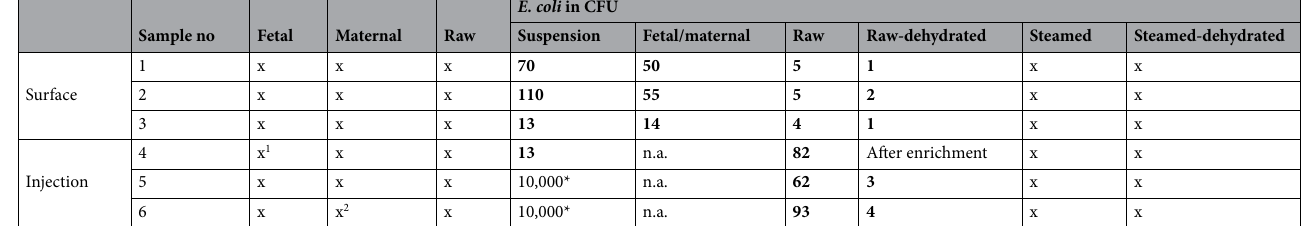
Table 5. Growth of E. coli in colony forming units (CFU) on different swabs and placenta tissue preparations. Further microorganisms were detected: 1 GBS 2 CFU, 2 Staphylococcus haemolyticus CFU 6. (x) no growth of E. coli after 48 h; (*) bacteria per ml; (n.a.) not analyzed. Significant values are in bold.